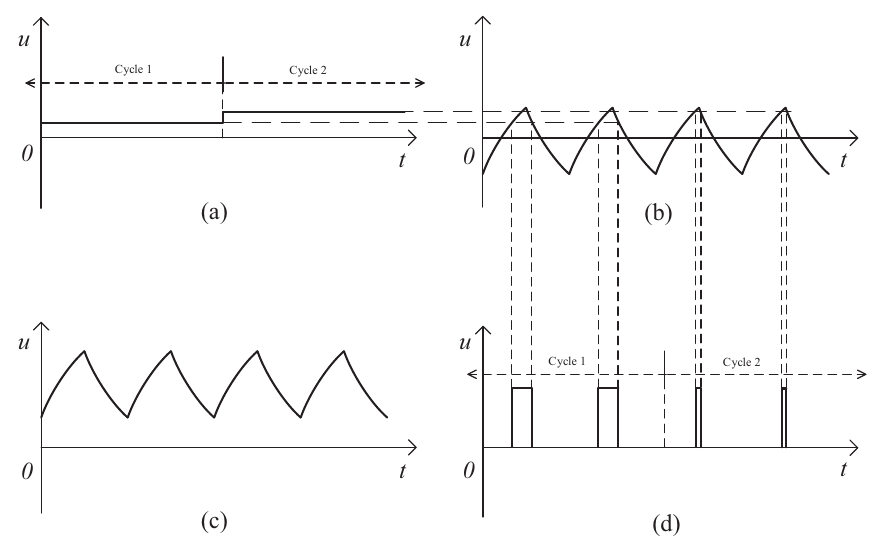
Figure 3. Waveform of key nodes in Figure 2. ( a ) The DAC output, with constant voltage in each feedback cycle. ( b ) The HPF output, only maintaining an AC ripple. ( c ) The SMPS output, containing a